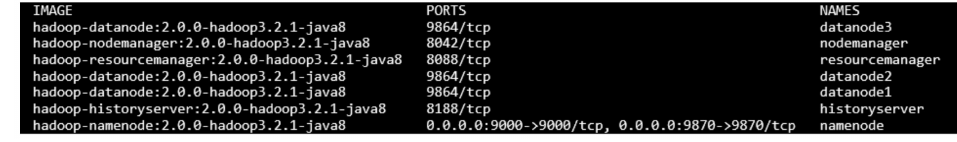
Figure 2. Under test Hadoop